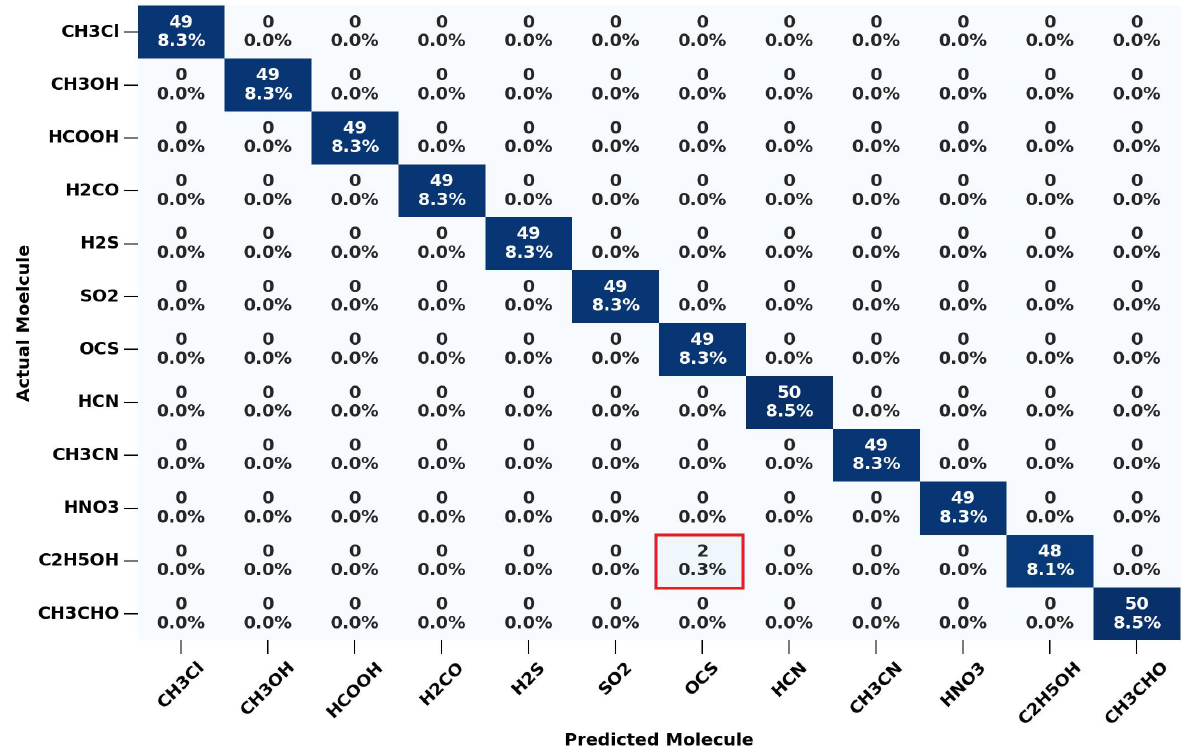
Figure 9. Confusion matrix for the classification of 591 simulated validation spectra. Red boxes indicate misclassifications.